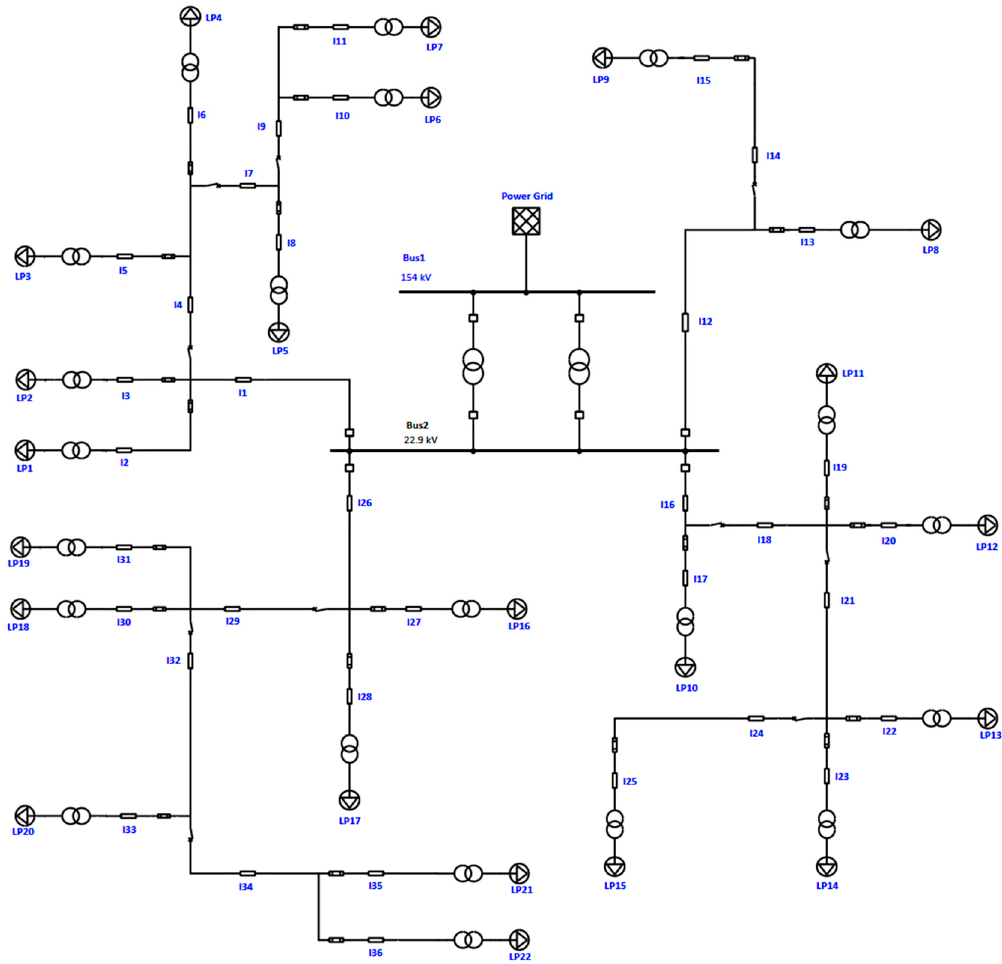
Figure 6. The modified RBTS Bus 2.